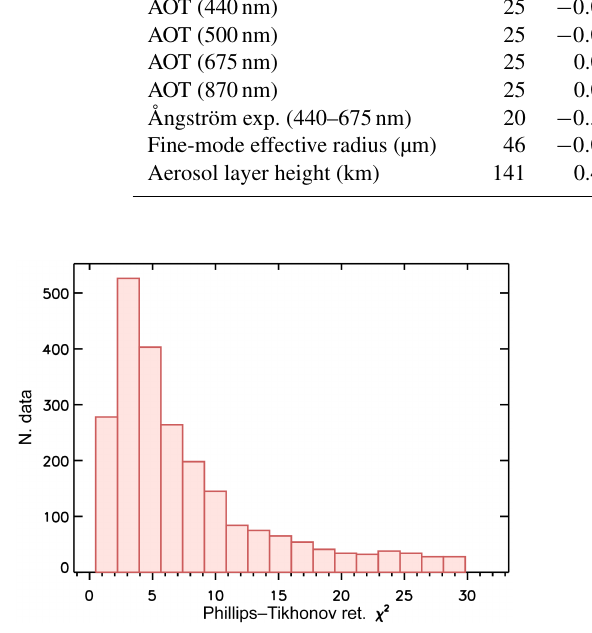
Figure 11. Histogram of the goodness-of-fit parameter ( χ 2 ) of all the available